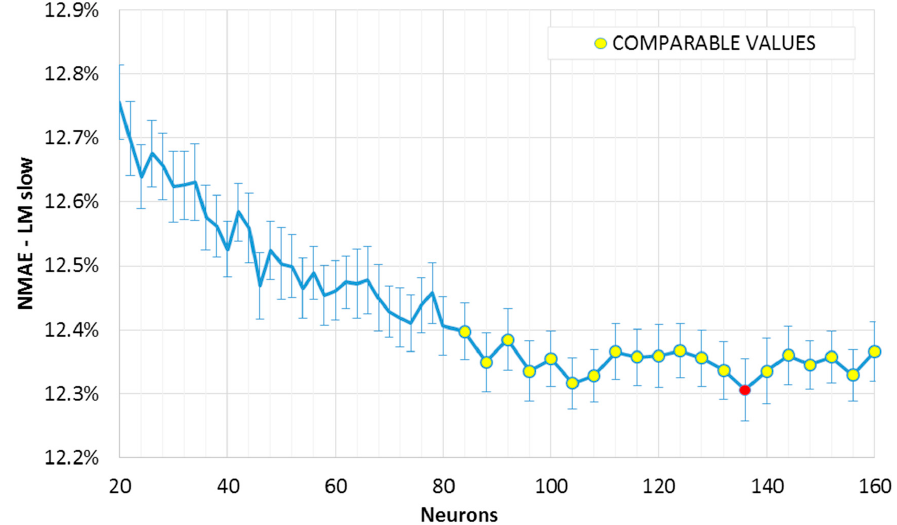
Figure 2. Mean NMAE % as a function of the number of neurons, with Levenberg–Marquardt training algorithm set for a slower convergence. Comparable mean NMAE % in yellow, with 95% interval of confidence, with the minimum in red.